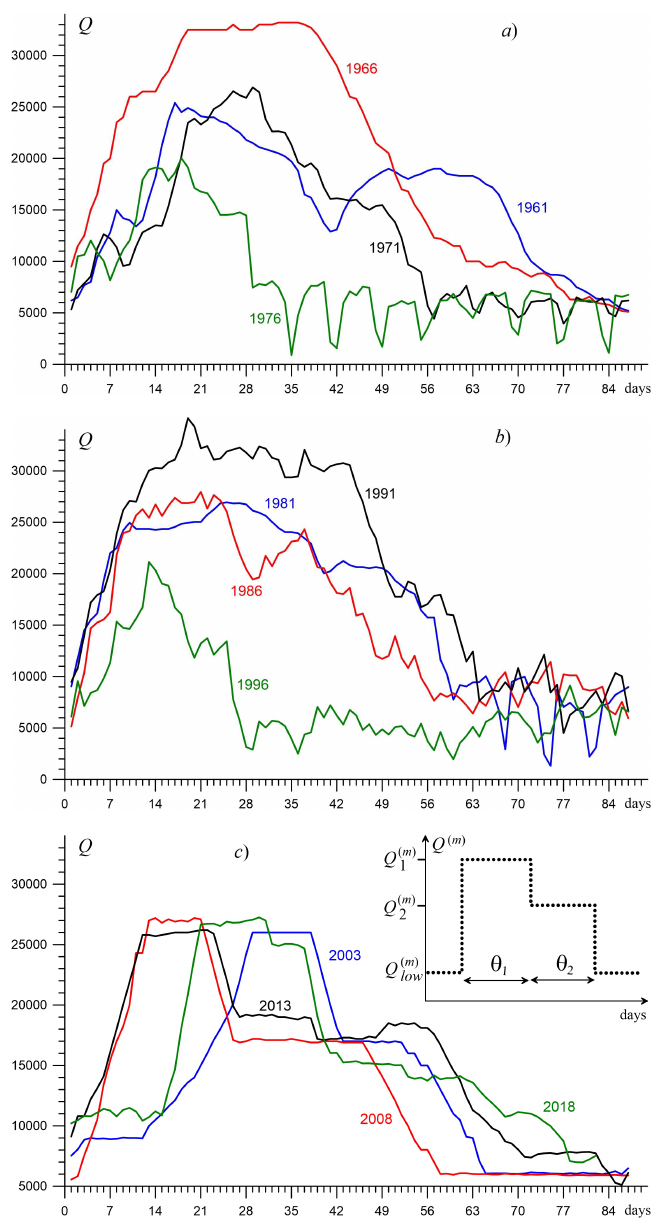
Figure 2. Examples of a flood discharge function (hydrograph) of the VHPS Q ( t ) in different periods of its operation: ( a ) 1961–1980; ( b ) 1981–2000; ( c ) 2001–2021, inset shows a model of so-called